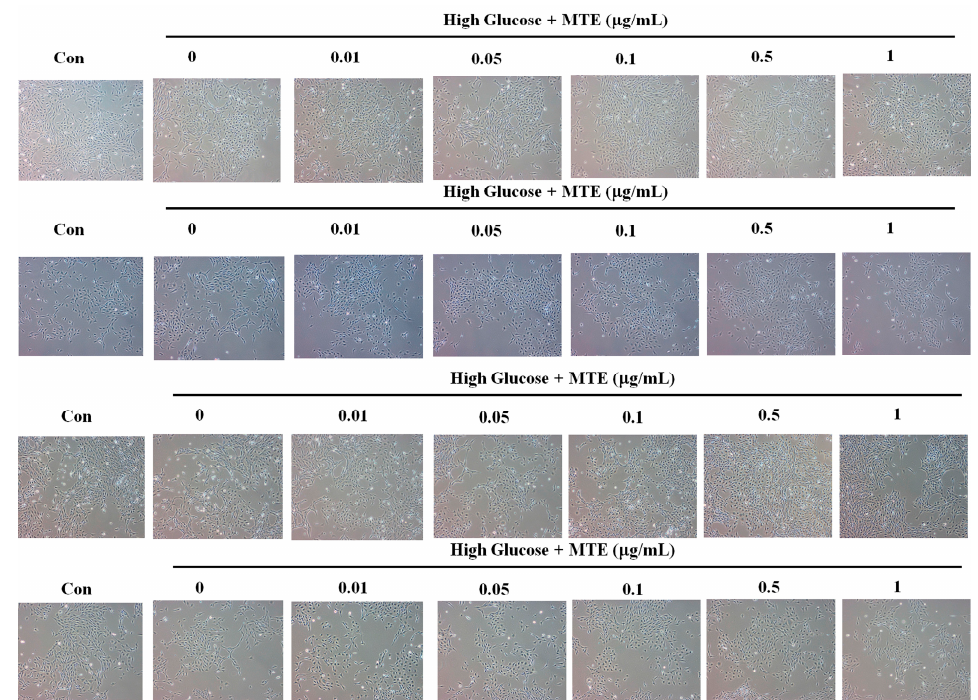
Figure 1. Cytotoxicity of prenylflavanone compounds of mouse renal mesangial cells. The mouse renal mesangial cells were treated with the indicated concentrations of MTE for 12, 24, 48, and 72 h (from upper to lower). The cell morphology was pictured by light contract microscope.